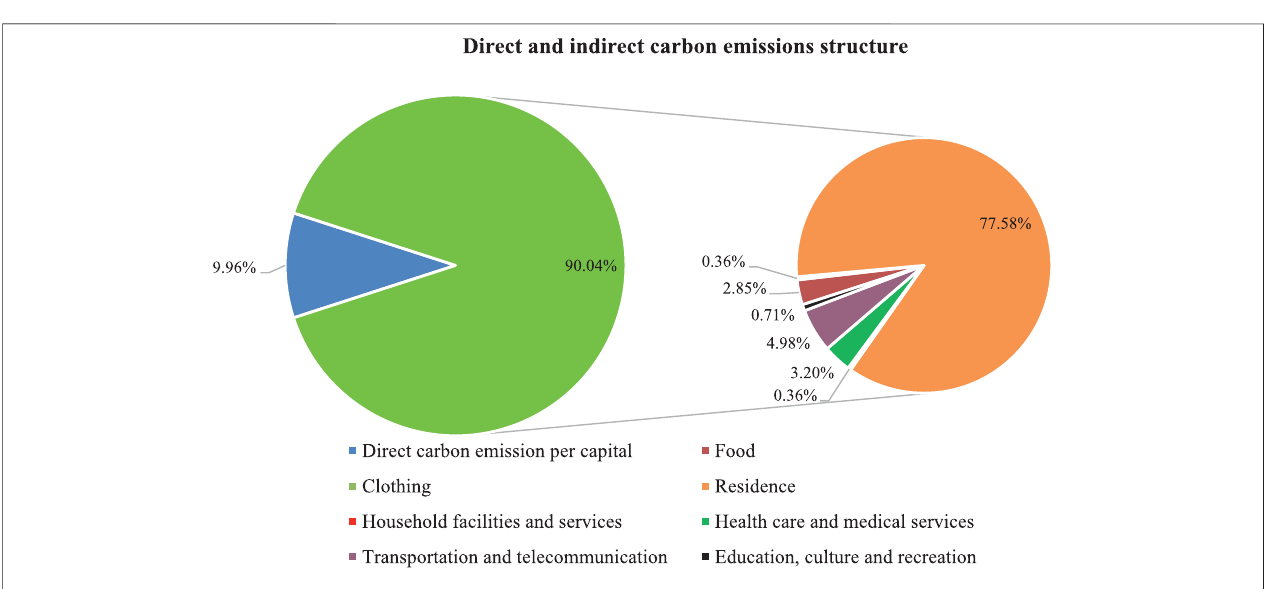
FIGURE 3 | Household carbon emissions across wealth percentiles.